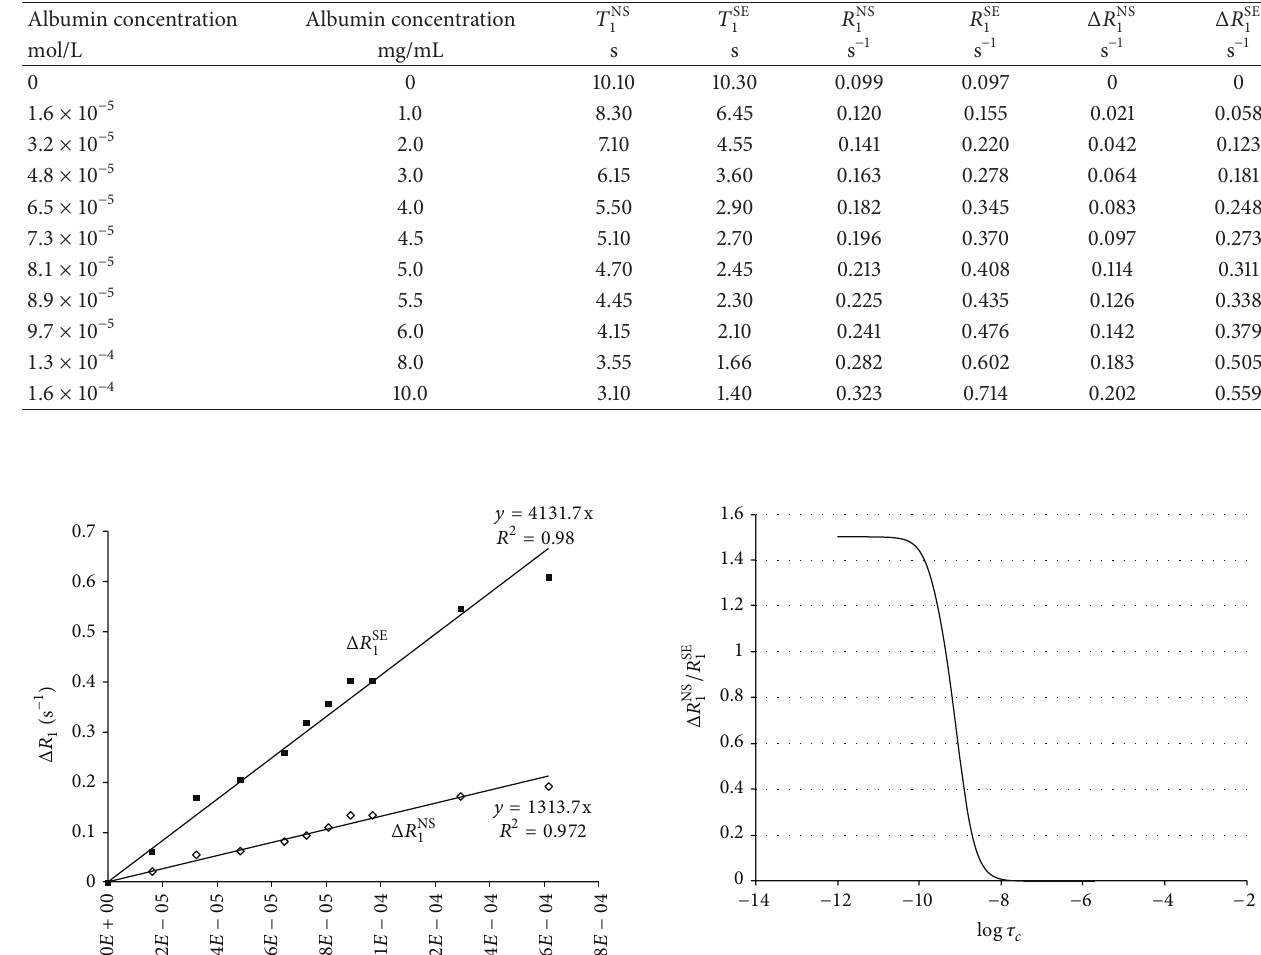
Figure 4: Computed values of Δ𝑅 NS 1 /Δ𝑅 SE 1 ratio as a function of 𝜏 𝑐 at a proton frequency of